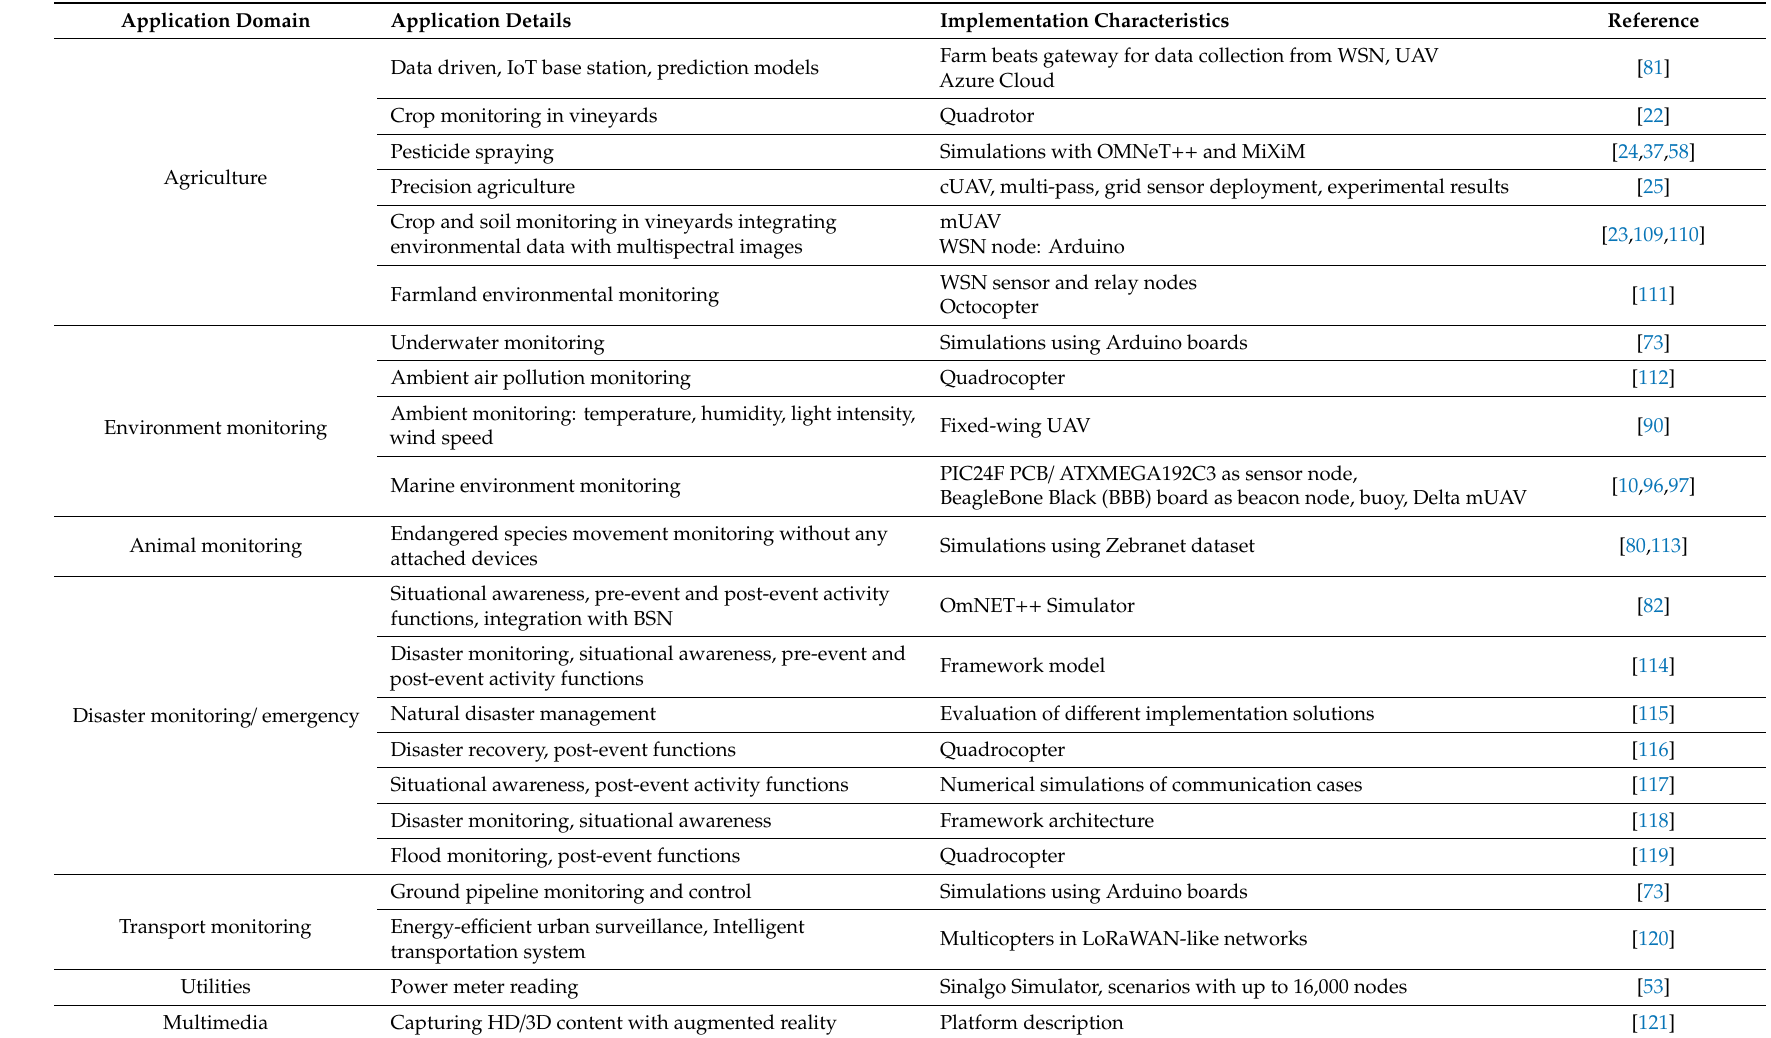
Table 5. Main applications of the integrated UAV–WSN